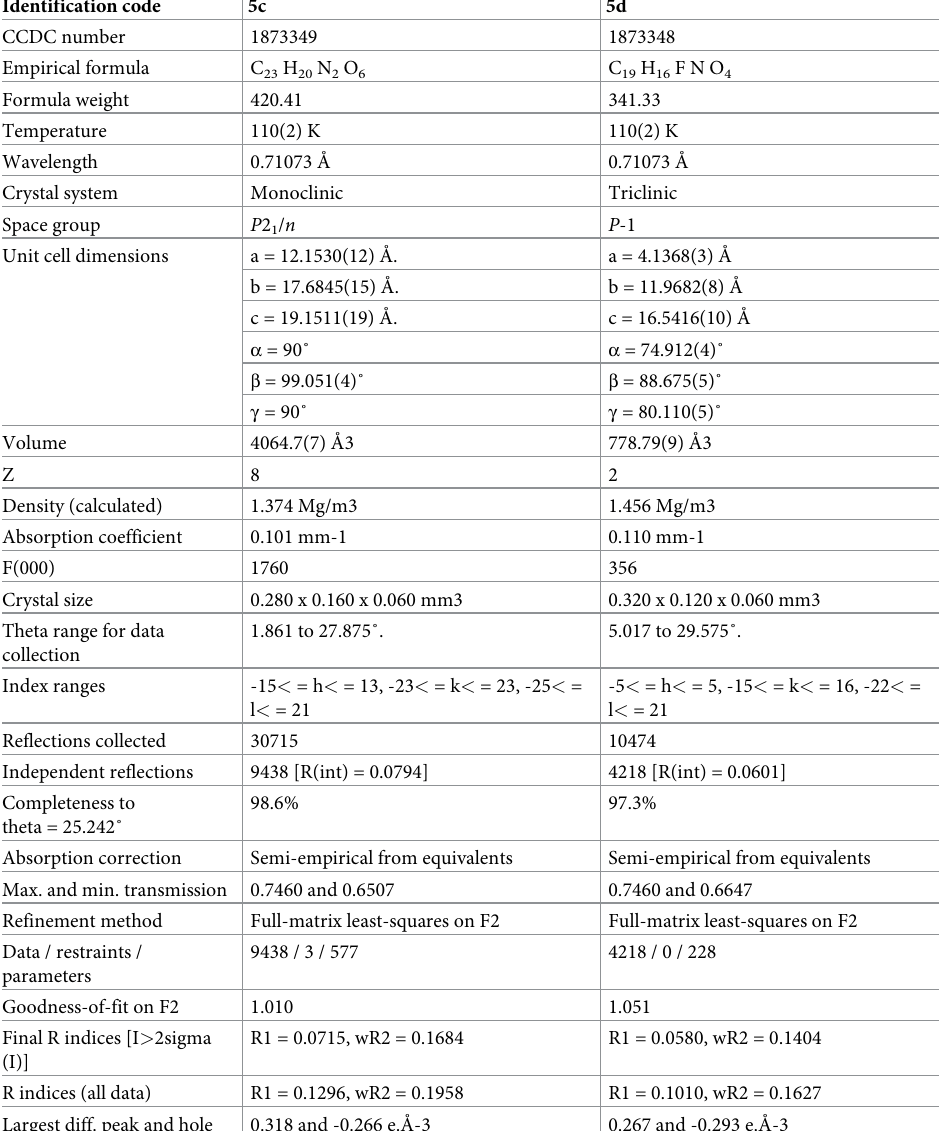
Table 2. Single crystal data and structure refinement parameters for 5c and